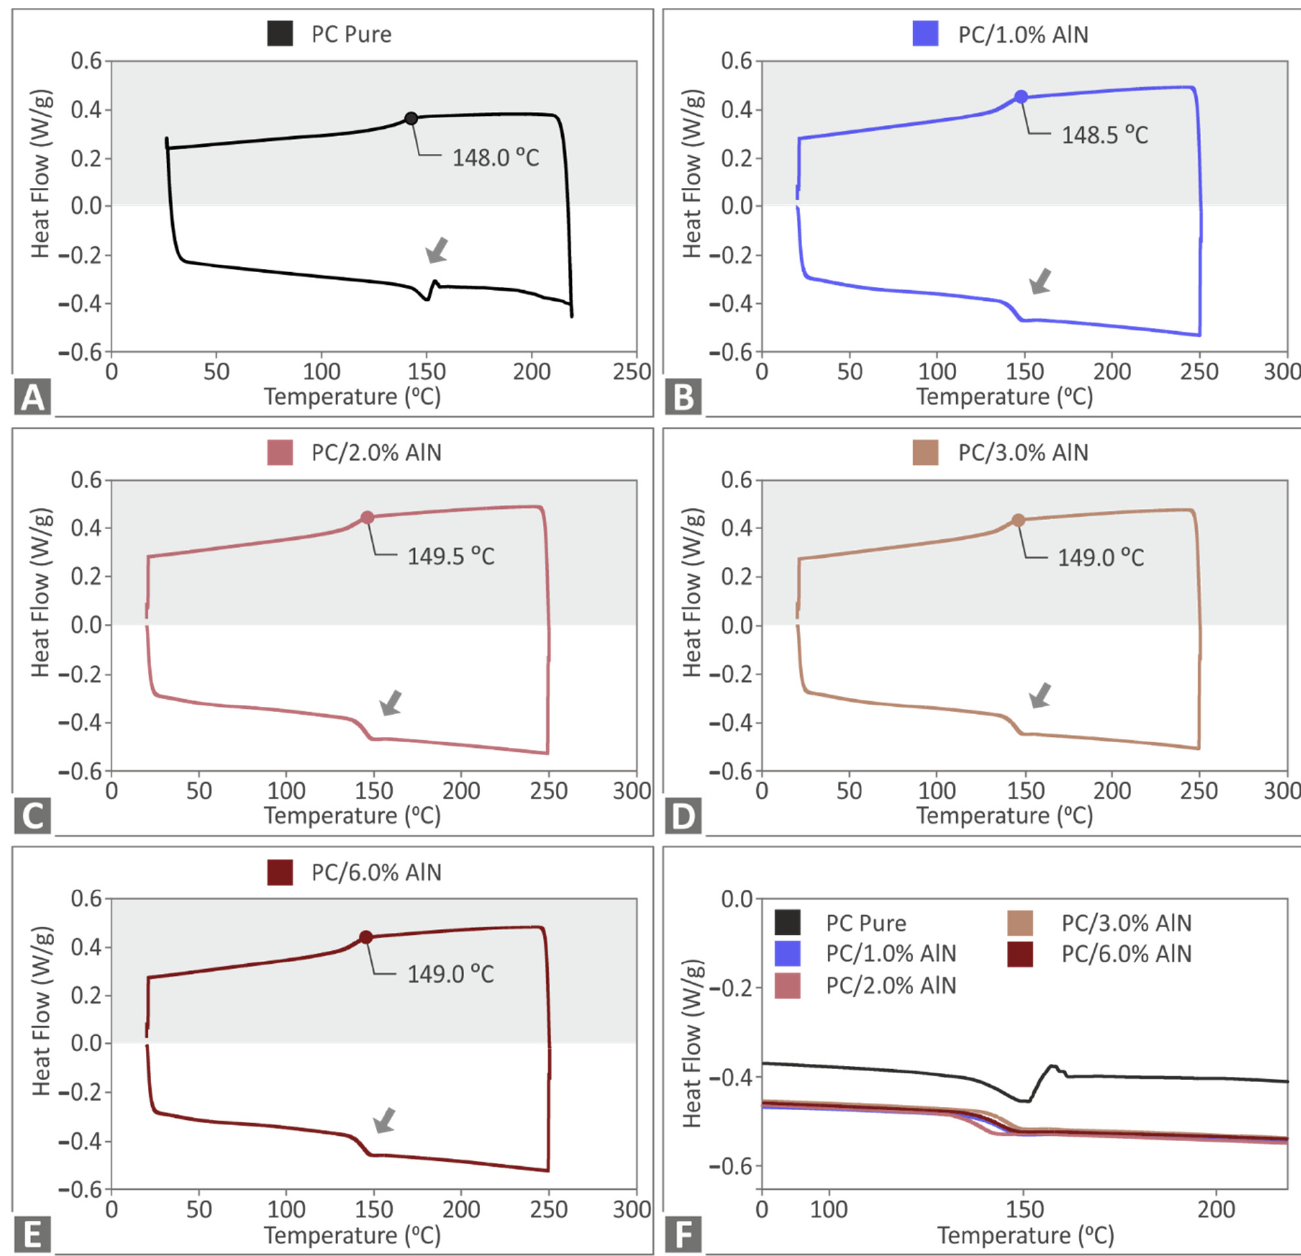
Figure 4. Heat flow curves (exothermic and endothermic) as a function of temperature for ( A ) pure PC, ( B ) PC/AlN 1 wt.%, ( C ) PC/AlN 2 wt.%, ( D ) PC/AlN 3 wt.%, ( E ) PC/AlN 6 wt.%, and ( F ) comparison of exothermic curves. Arrows indicate the phase transition of the material.